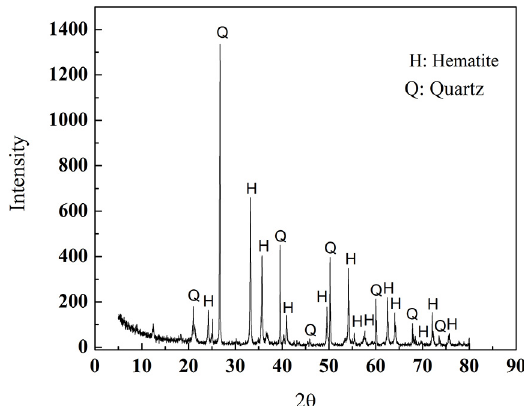
Figure 1. XRD diffractogram of iron ore